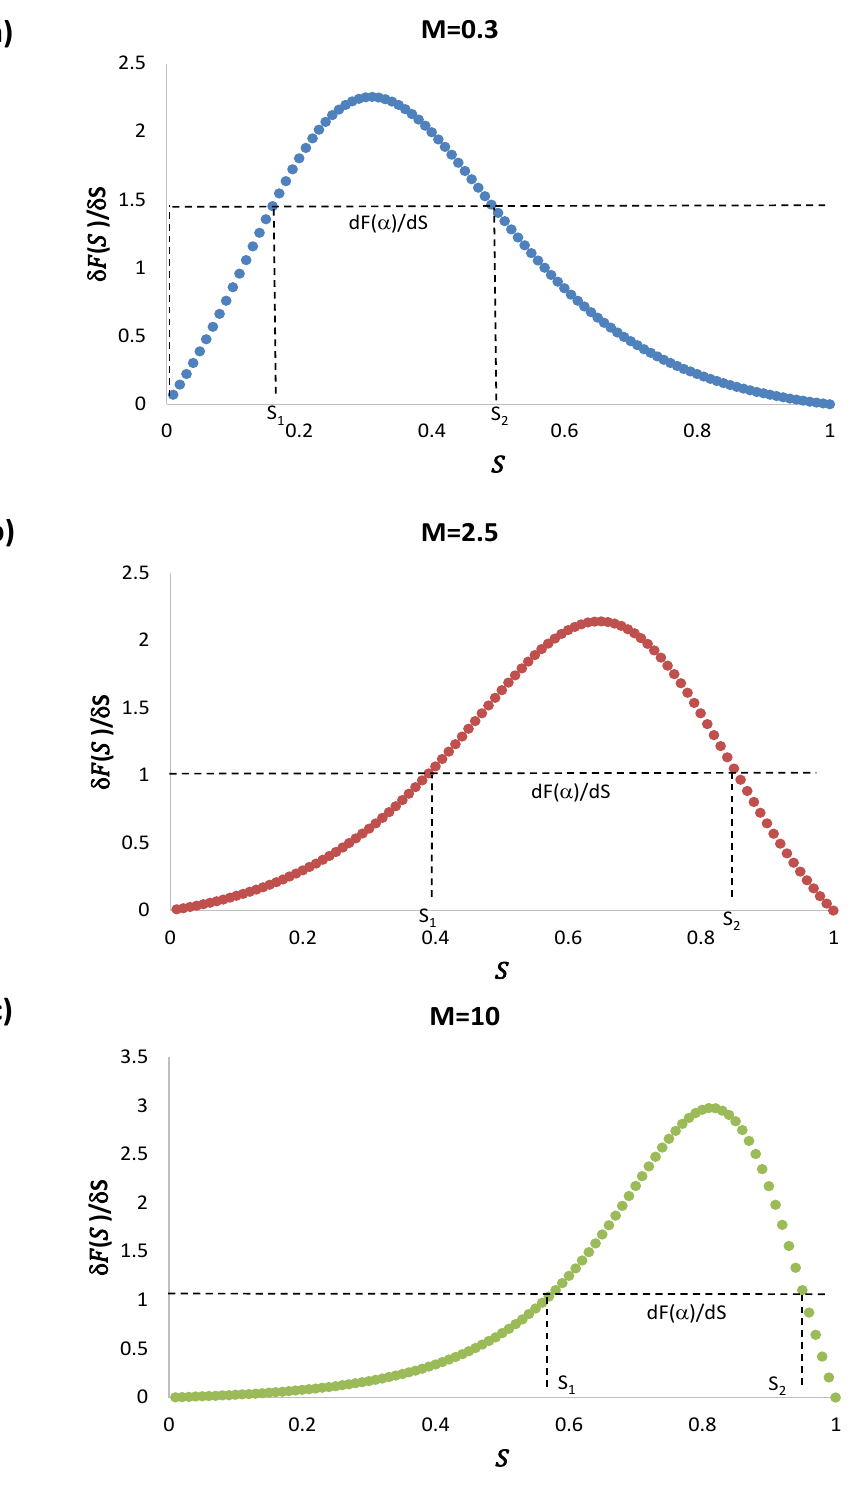
Figure 8. The derivative ∂ f as a function of the saturation for three different mobility ratios ( a ) M = 0.3, ∂ S ( b ) M = 2.5, and ( c ) M = 10, illustrating the equal areas criterion. Here, f (cid:48) ( S ∗ ) denotes the ordinate at which the equal area criterion